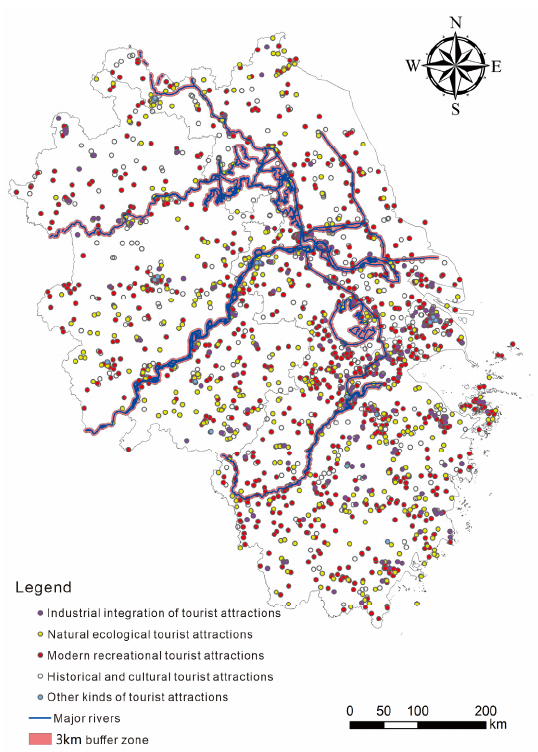
Figure 6. Coupling of the river system and the spatial distribution of tourist attractions.